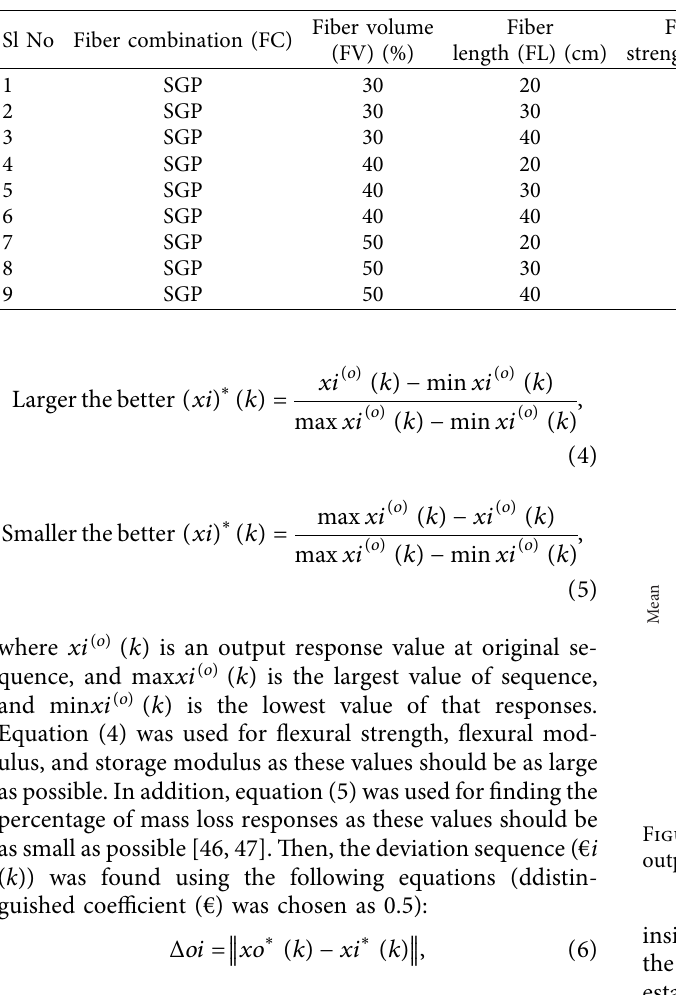
Table 5: Output responses (samples).